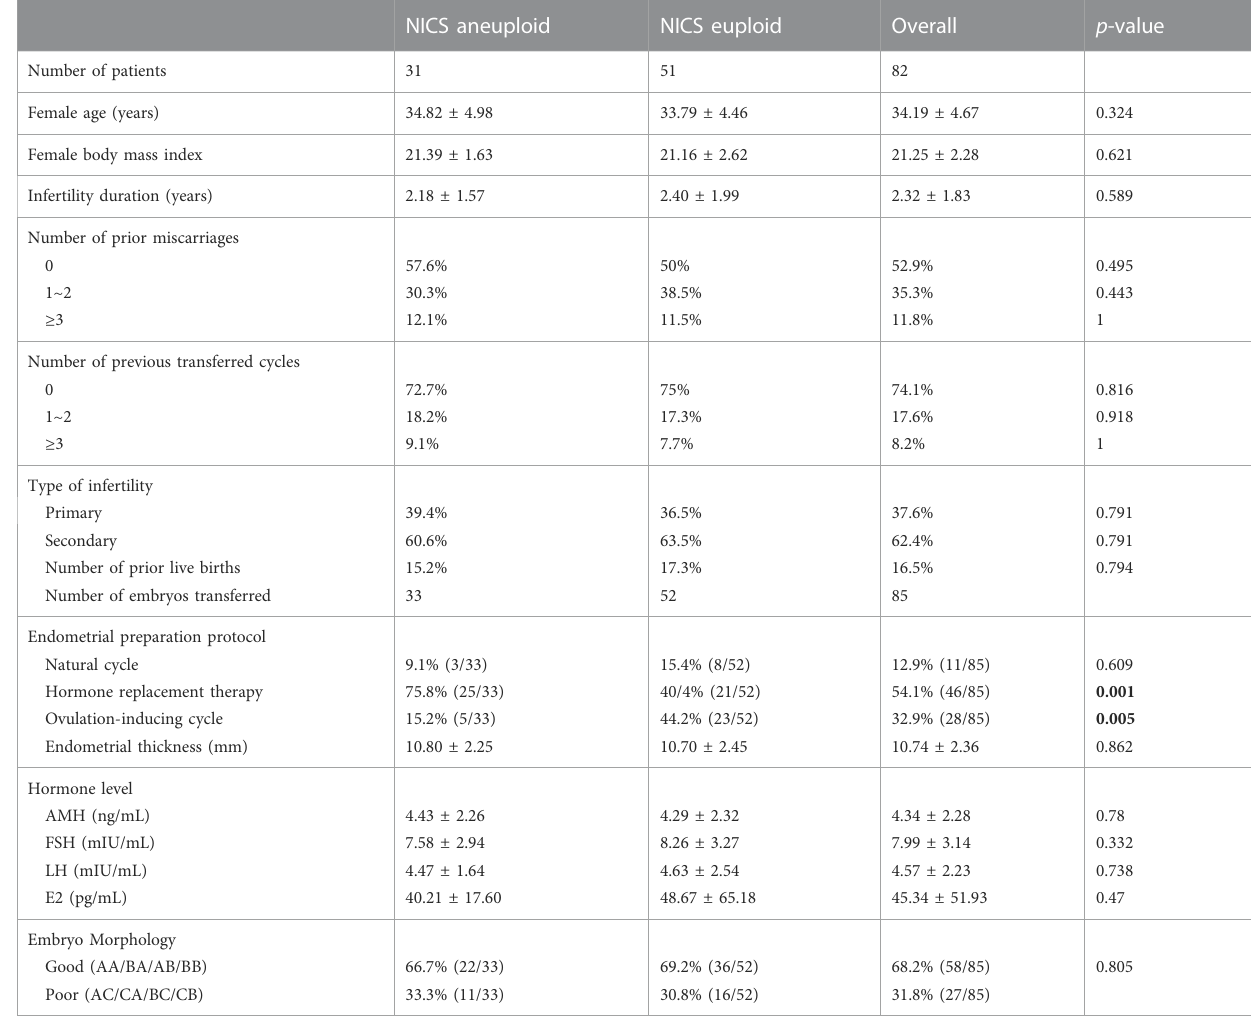
TABLE 3 Clinical baseline characteristics of patients.